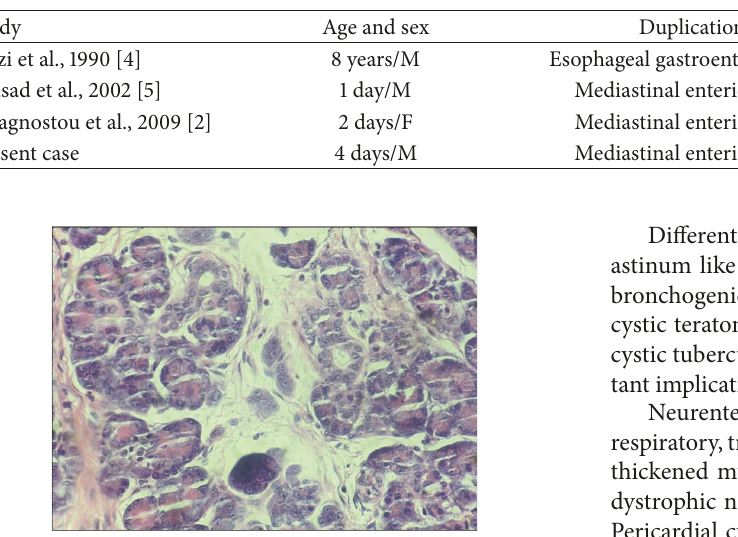
bronchi or lung, cough, cyanosis, retrosternal pain, and dys- phagia. Children may present with recurrent chest